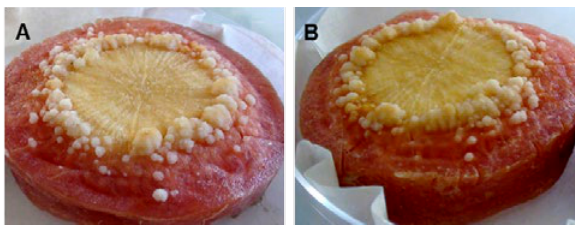
Figure 6. Carrot discs showing morphologically indistin- guishable galls induced by Agrobacterium fabrum C58 (A) and its mutant